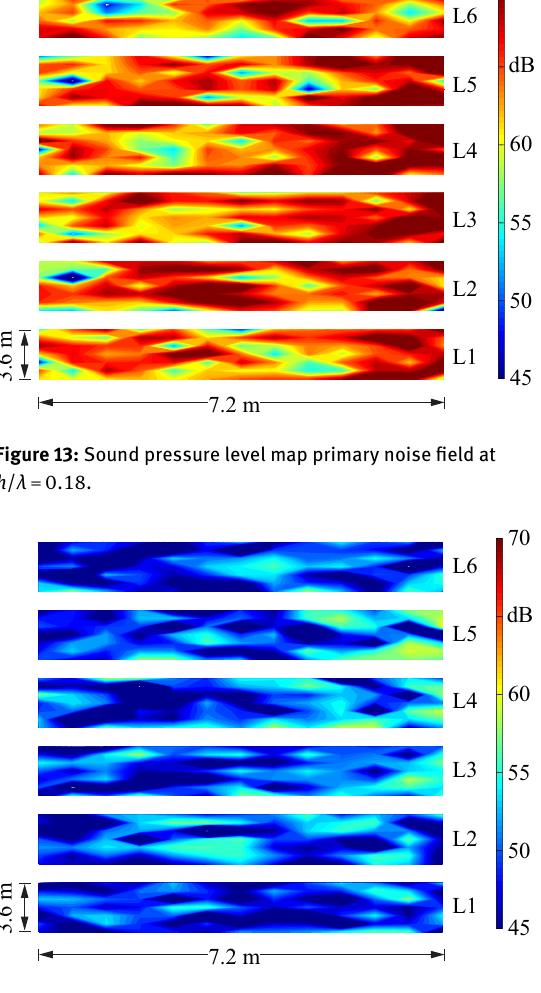
Figure 14: Sound pressure level map residual noise field at h / λ =0.18